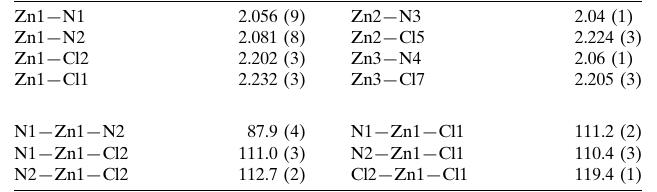
Selected geometric parameters (A˚ , (cid:2) ).